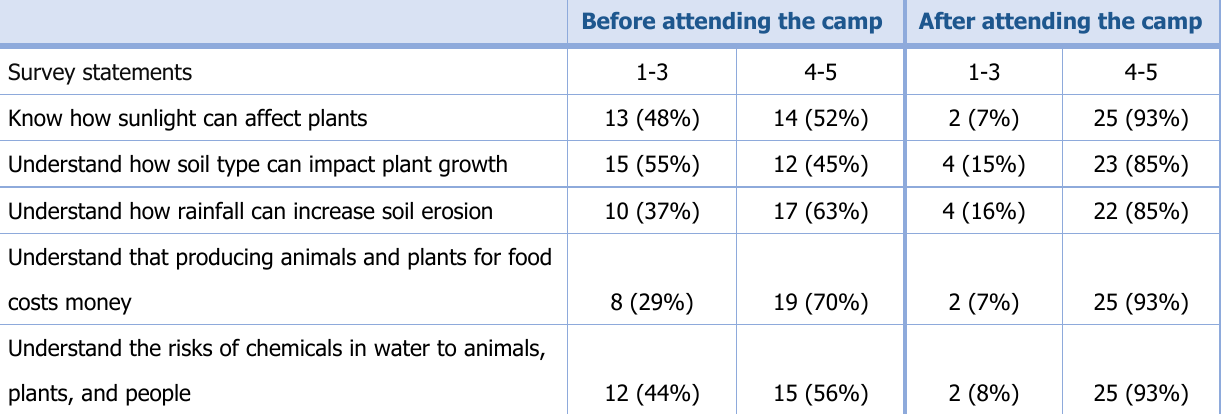
Table 1. Frequency Distribution of Students Based on Self-Reported Knowledge Levels Before and After Attending the